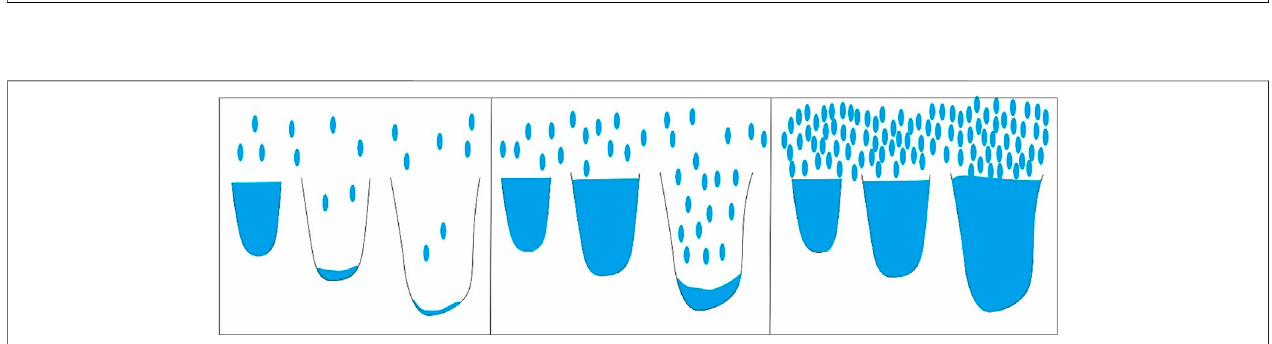
FIGURE 8 | Moisture adsorption process in different pores (modi fi ed from Yang et al., 2020).